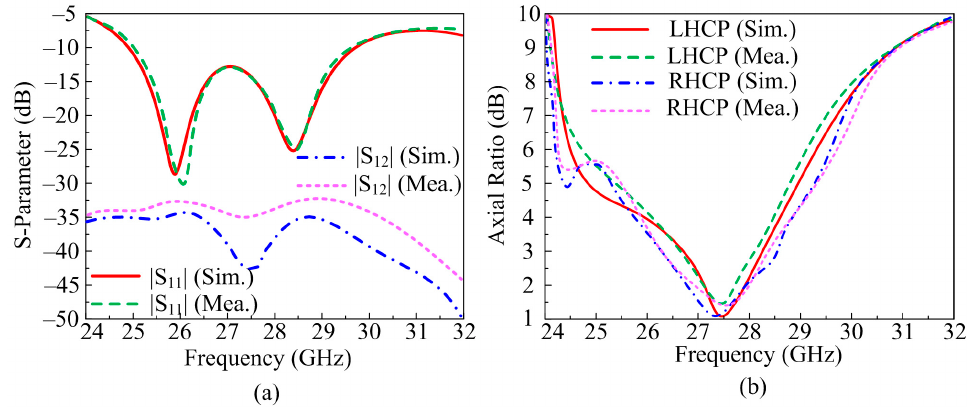
Figure 7. Comparison parameter of MIMO antenna with parallel element placement among ( a ) scattering parameters ( b ) axial ratio.